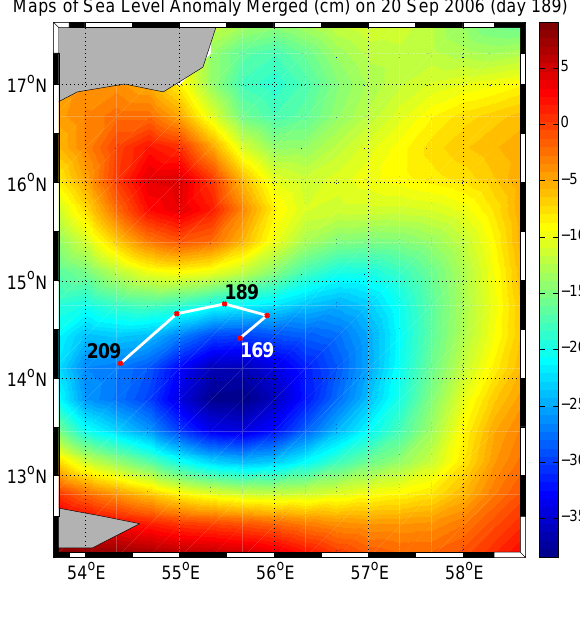
Fig. 16. Trajectory of float 2900104 in the Arabian Sea, superim- Figure 16: Trajectory of float 2900104 in the Arabian Sea, superimposed on bathymetry, posed on bathymetry, year 2. A red dot indicates the position of the year 2. A red dot indicates the position of the float every 20 days. float every 20